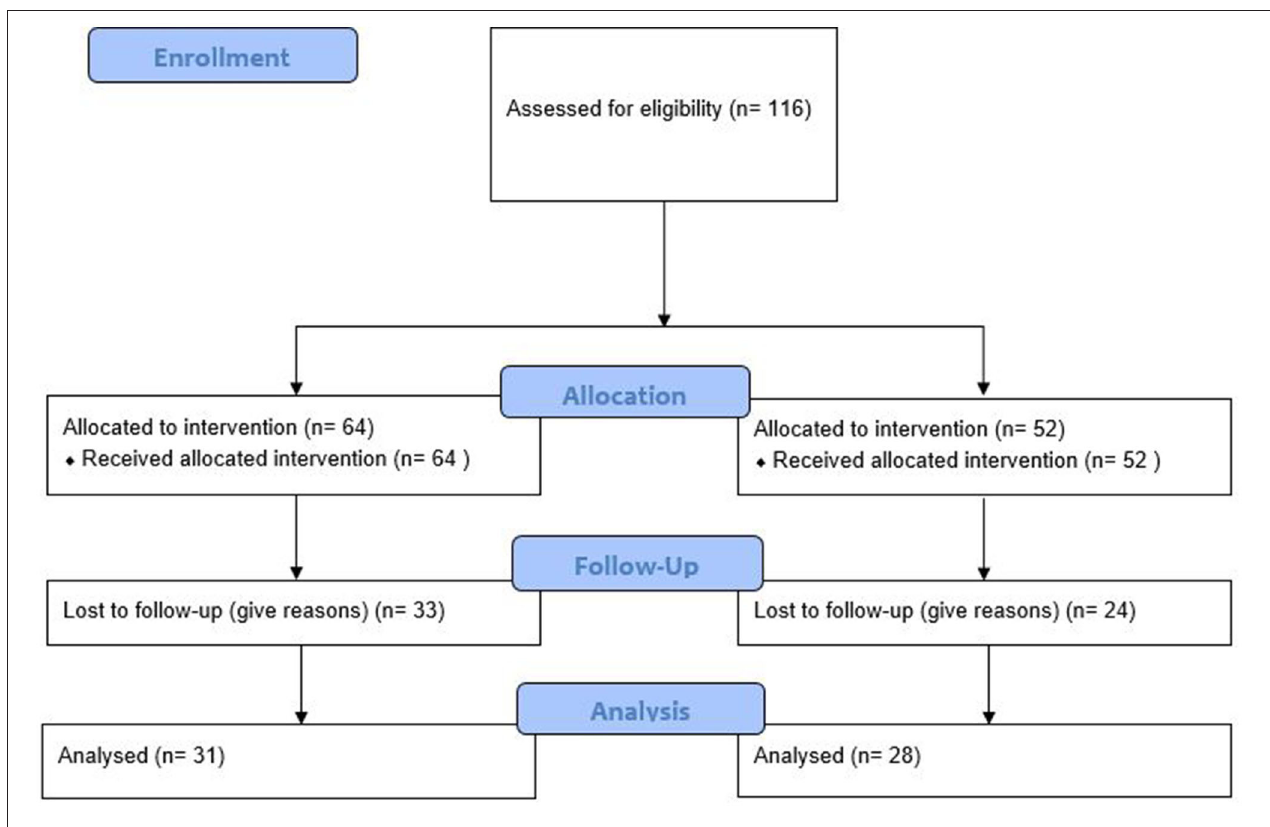
FIGURE 1 | Study flow diagram.